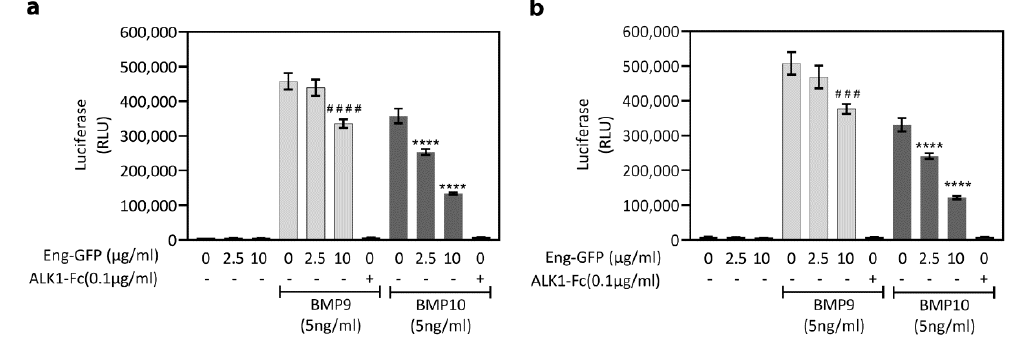
Figure 5. Endoglin–GFP (Eng–GFP) fusion protein attenuates BMP9 and BMP10 signaling in C2C12-BRE cells. BMP9 or BMP10 (each 5 ng/mL) were preincubated with endoglin–GFP (2.5 µg/mL or 10 µg/mL) or ALK1-Fc (100 ng/mL) for 18 h at either ( a ) RT or ( b ) 37 °C. Mixes were then added to C2C12-BRE cells ( n = 4 wells/treatment) for 6 h, followed by cell lysis with One-GLO™ reagent and luciferase activity measurement. Data are representative of n = 3 separate experiments. ### p < 0.0005 and #### p < 0.0001 relative to BMP9, and **** p < 0.0001 relative to BMP10, one-way ANOVA.